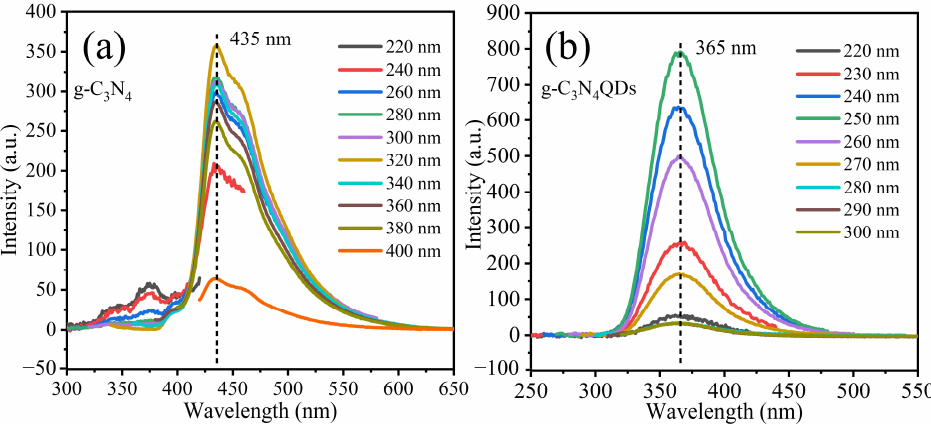
Figure 4. PL spectra of g-C 3 N 4 ( a ) and g-C 3 N 4 QDs ( b ). As shown in Figure 5a–d, the fluorescence quenching intensity of g-C 3 N 4 QDs